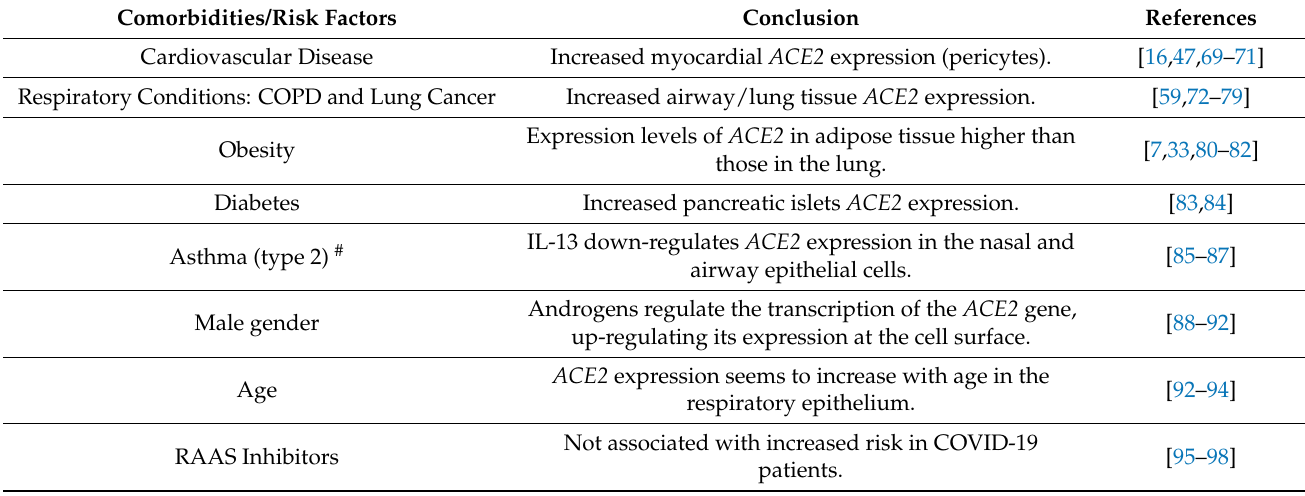
Table 1. Correlation between ACE2 expression and comorbidities/risk factors associated with COVID-19 severity. Comorbidities/Risk Factors